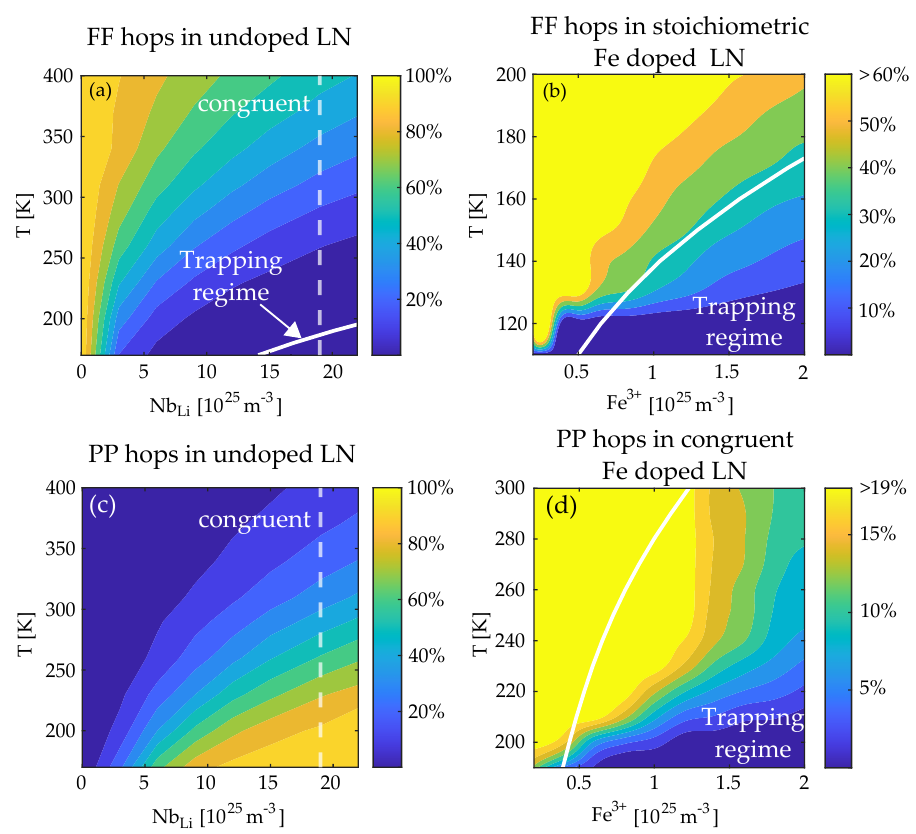
Figure 4. ( a ) Fraction of hops as a free polaron N FF /N tot as a function of temperature and [ Nb Li ] concentration for an undoped sample ([Fe] = 0). ( b ) Fraction of hops as a free polaron N FF /N tot as a function of the temperature and [Fe] concentration for a stoichiometric sample ([ Nb Li ] = 0 ) . The solid lines represent the theoretical boundary between the pure trapping regime calculated according to Equations (15) and (16). ( c ) N PP /N tot as a function of temperature and [ Nb Li ] concentration for an undoped sample ([Fe] = 0). ( d ) N PP /N tot as a function of the temperature and [Fe] concentration for a congruent sample ( [ Nb Li ] = 19 × 10 25 m − 3 ). Note the different temperature range in the two